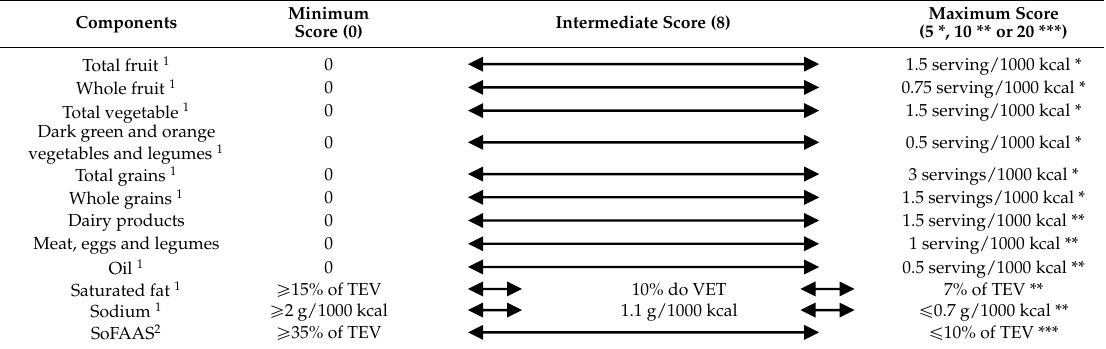
Table 2. Adaptation of the distribution of the scores of the components of the Healthy Eating Index.